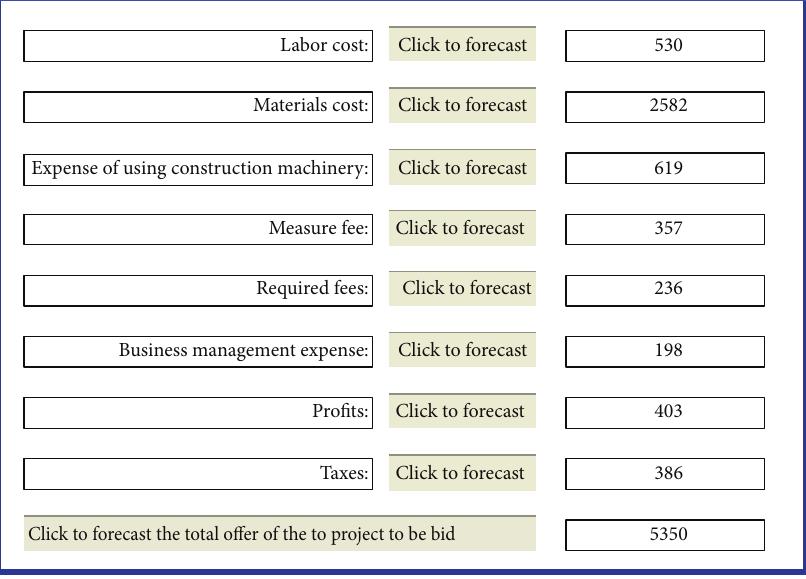
Figure 2: Calculation interface of the cost control software module in bidding